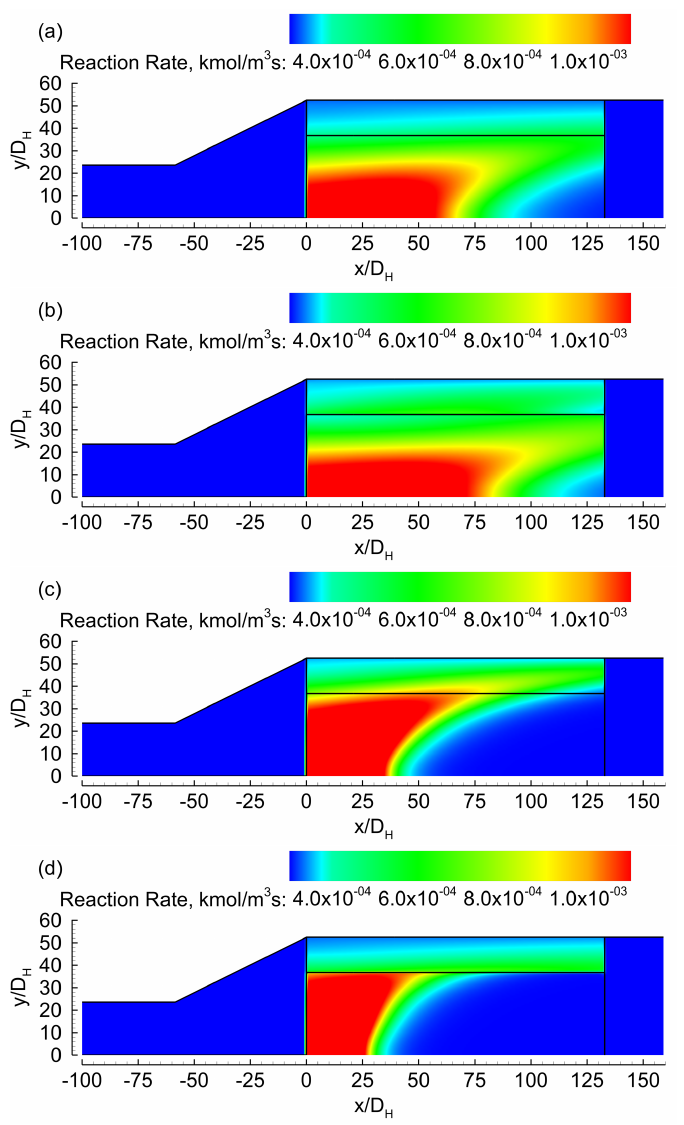
Figure 9. Reaction rate. ( a ) 400c/400r, ( b ) 400c/900r, ( c ) 900c/900r, and ( d )